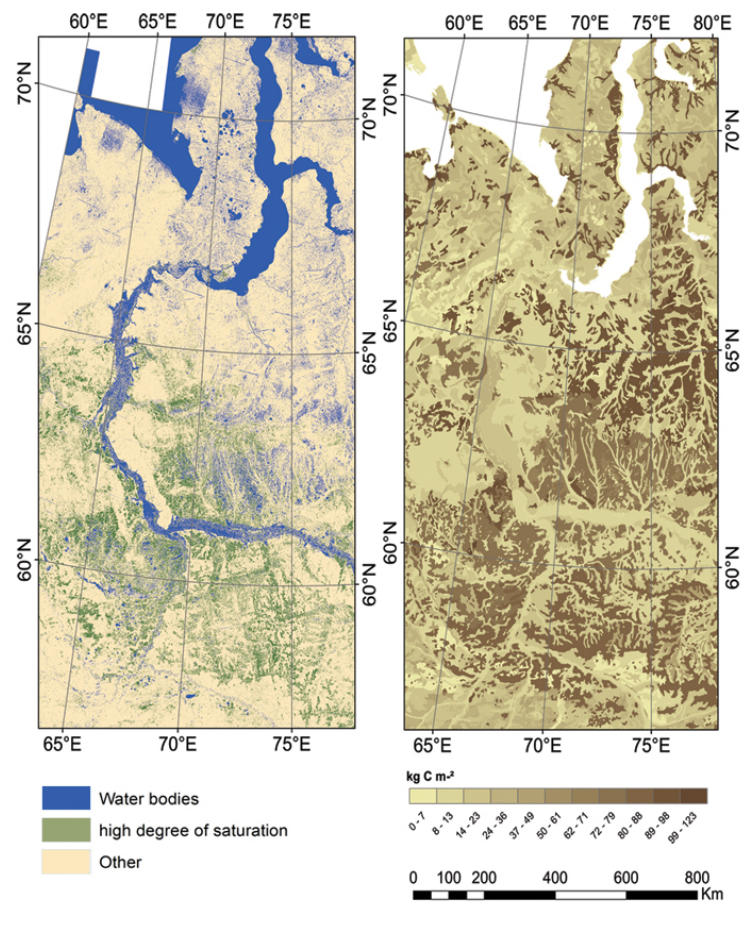
Figure 8. Comparison of h S data set [32]).